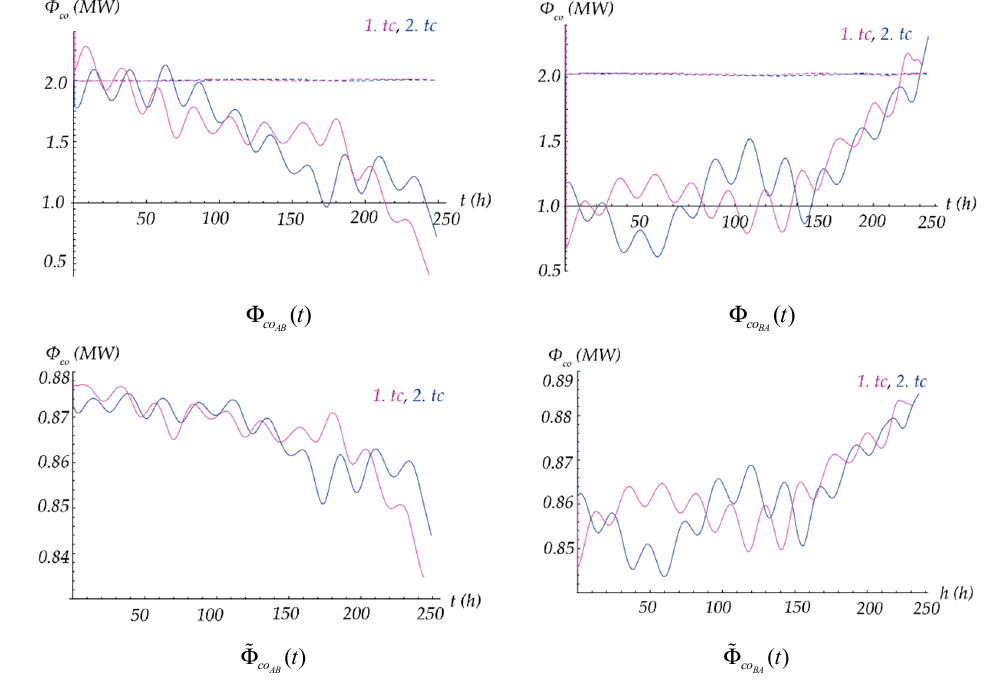
Figure 7. Unsteady cogeneration effects for navigation in first and second transport cycle.